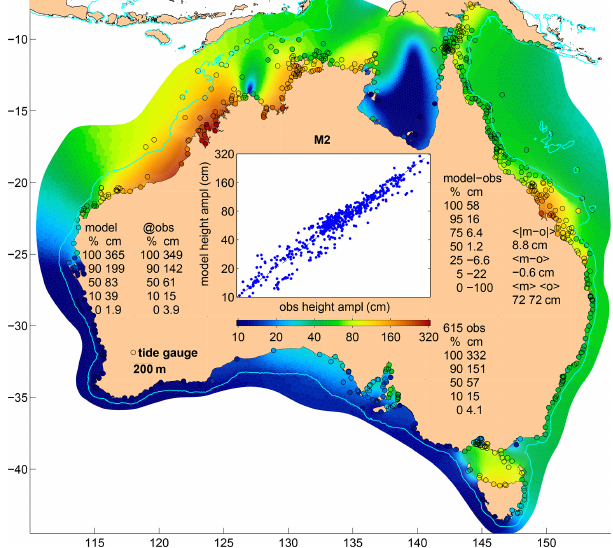
Figure 5. Amplitude of the M2 major axis velocity; otherwise like Fig. 3. Black (model, at a random subset of grid points) and magenta (observed) velocity ellipses use the scale